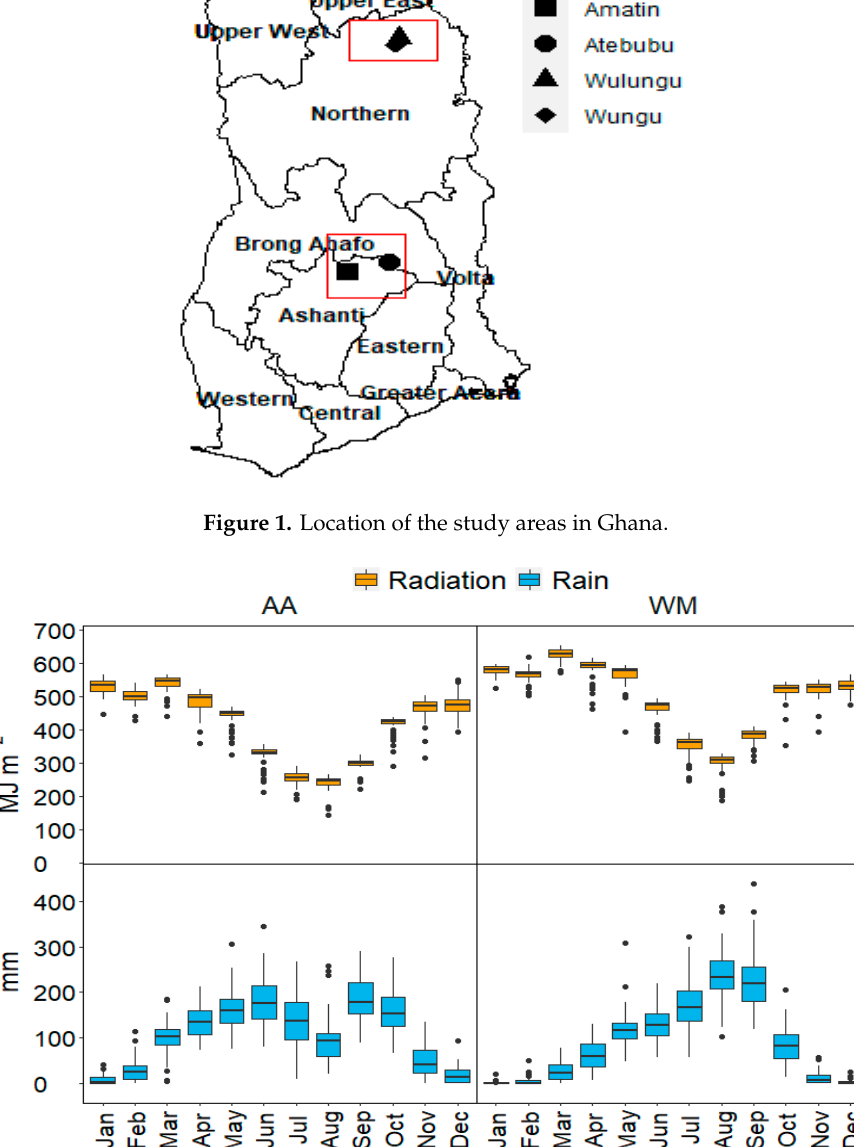
Figure 2. Long-term mean monthly total radiation and rainfall for Atebubu-Amantin (AA) and West Mamprusi (WM). The AA site has two seasons: major (Mar–Jul) and minor (Aug–Nov) season. The boxplot shows variability of rainfall and radiation. The lower horizontal line of the box represents the 25-percentile limit, and the upper horizontal line represents the 75-percentile limit. The line in the box represents the median radiation or rainfall. The dots below the 25 and above 75 percentile limits are